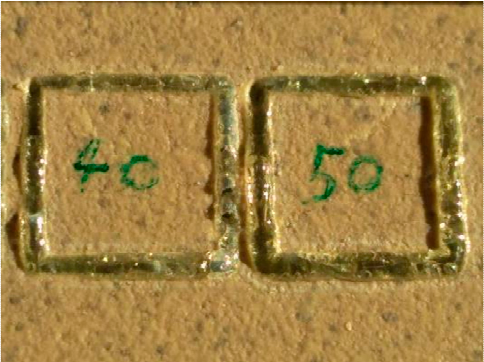
Figure 3. Laser cutting test. Laser: (10~50 W, 1 mm/s). Sample: 6 mm thick tiles.